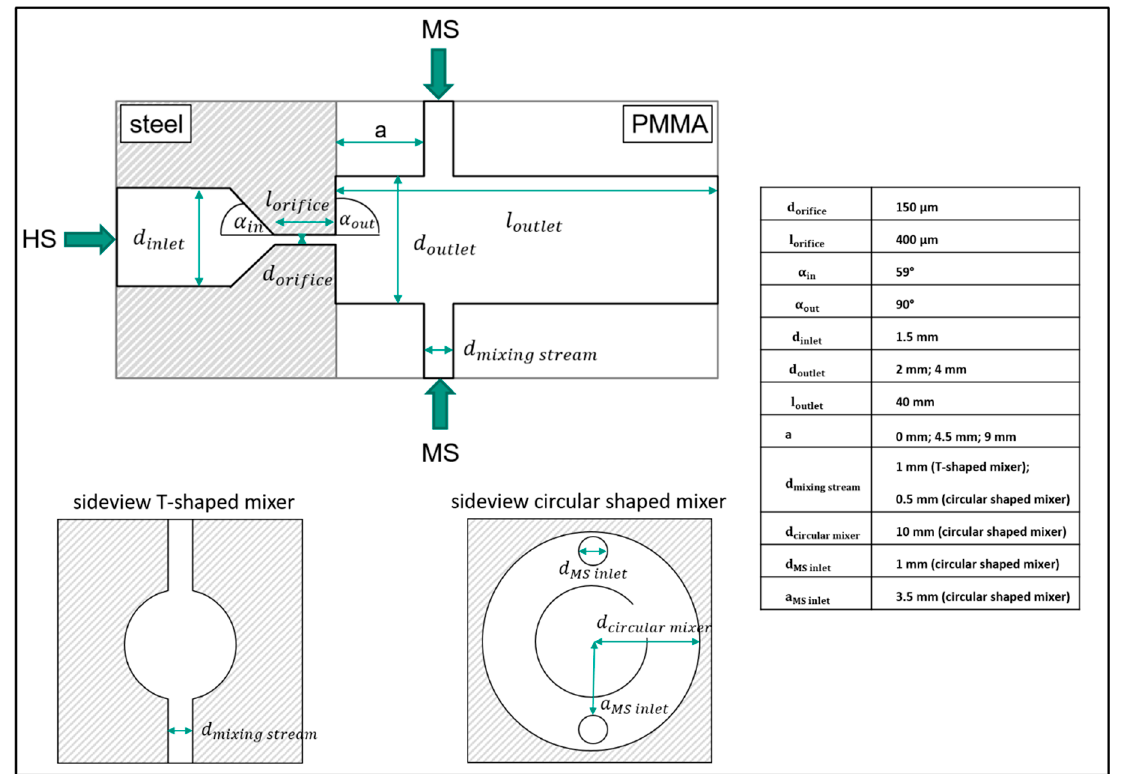
Figure 4. Geometry of disruption unit.